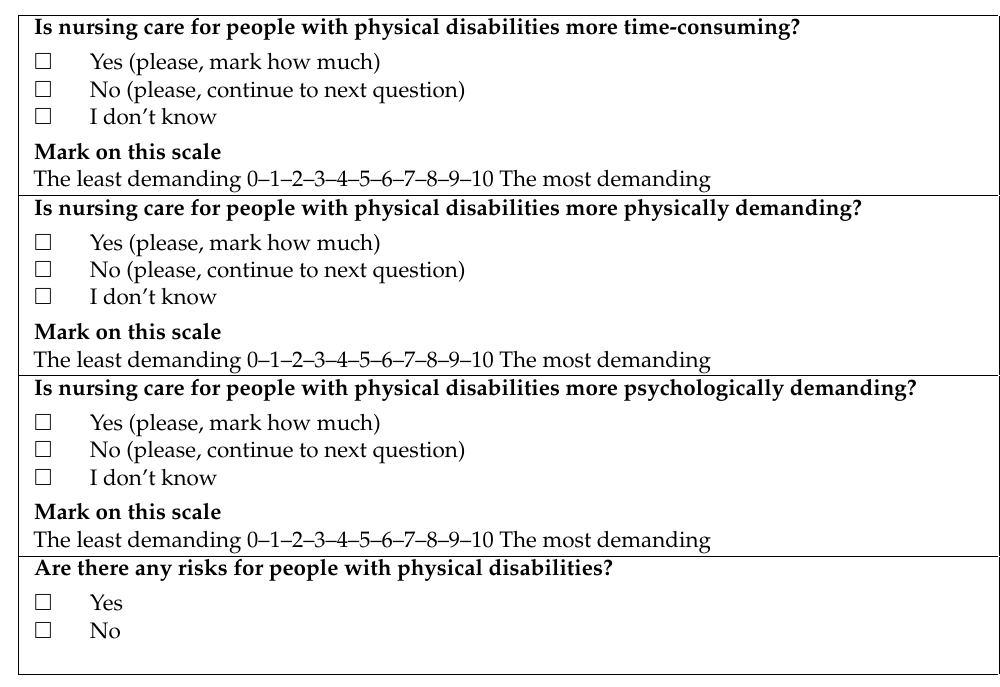
Table A2. Non-standardized